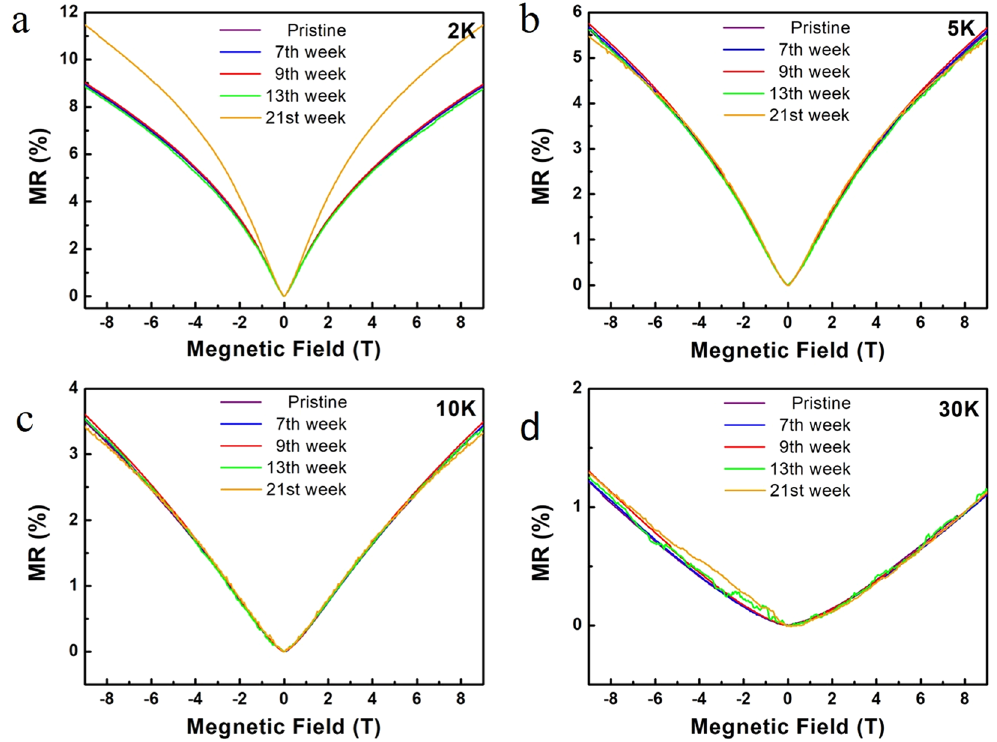
Figure 4. MR at θ = 90° with different exposure time in ambient air at ( a ) 2 K, ( b ) 5 K, ( c ) 10 K and ( d ) 30 K.